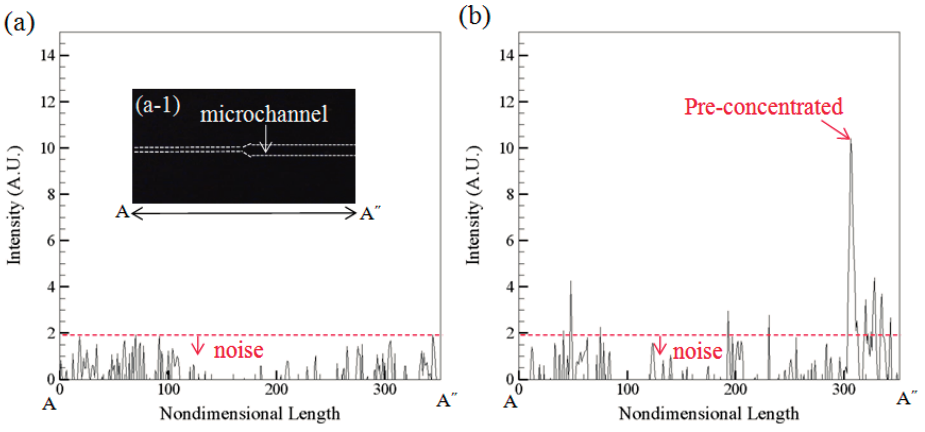
Figure 6. ( a ) The measured intensity along the microchannel A-A ˝ when the device contains buffer only; ( b ) The measured intensity along A-A ˝ when the device contains both buffer and 9.5 × 10 − 6 mg/L CRP under the pre-concentration 30710